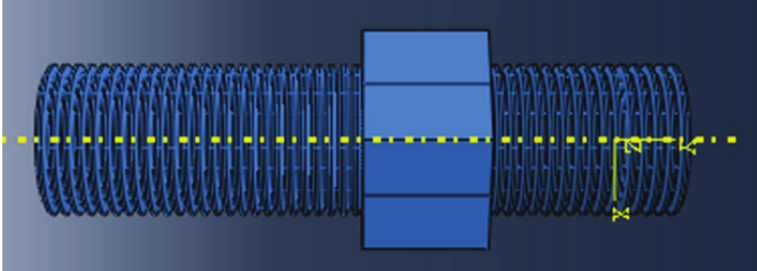
Figure 2. Axisymmetric model of the bolted connection.